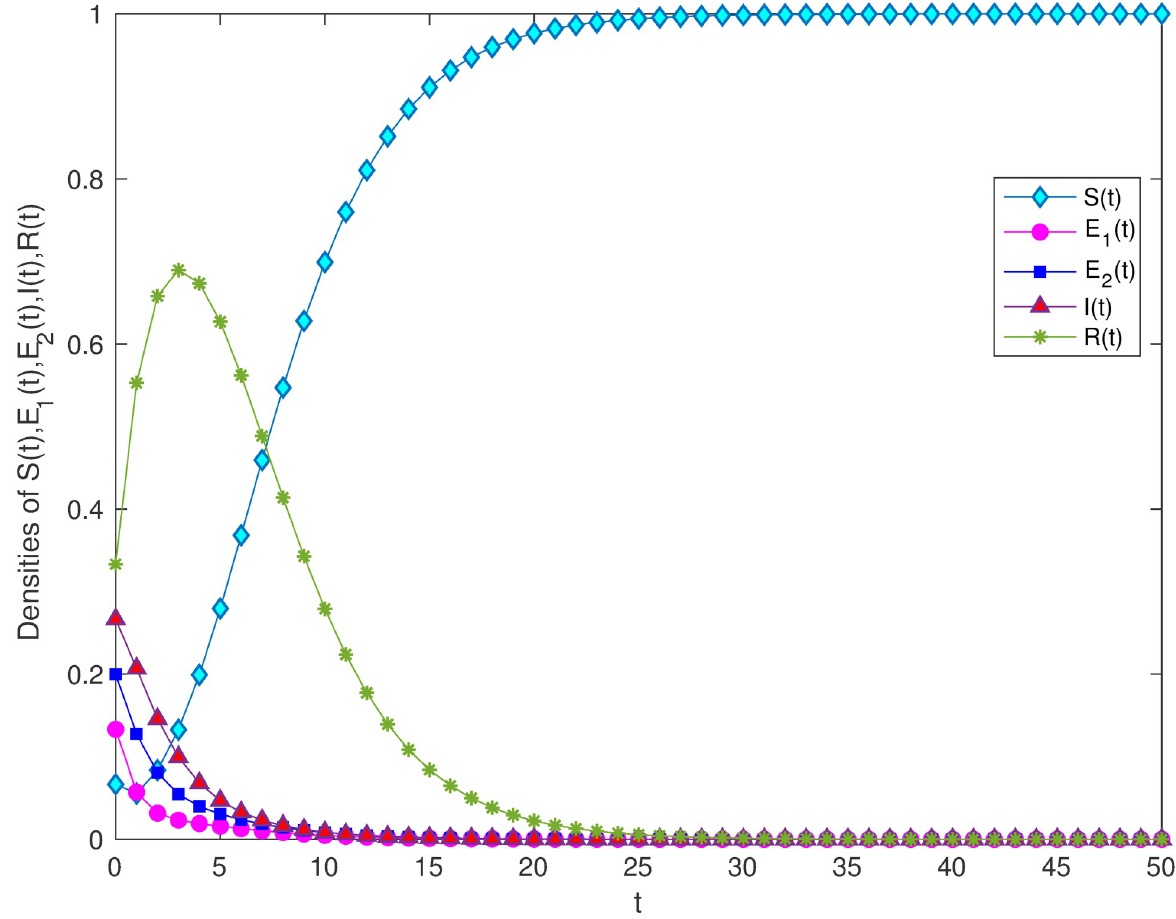
Fig 2. The stability of information-free equilibrium E 0 of system 1 with R 0 < 1.